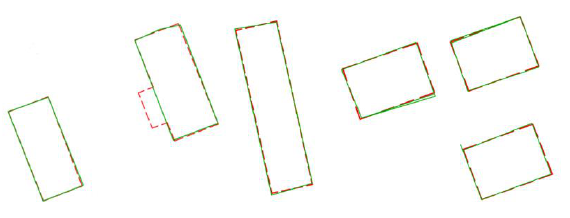
Figure 13 . Some examples from the manually (red) and automatically (green) detected buildings.